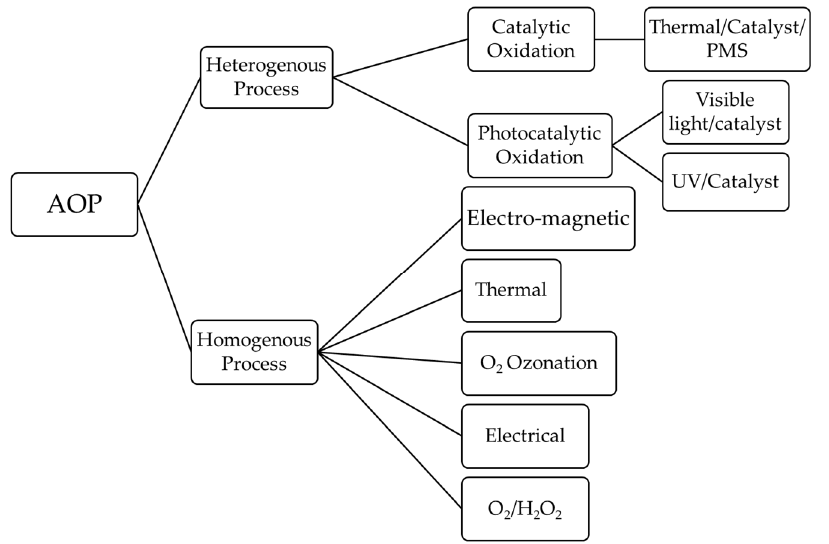
Figure 5. A diagram of the currently available advanced oxidation processes for the removal of mi- croplastics.